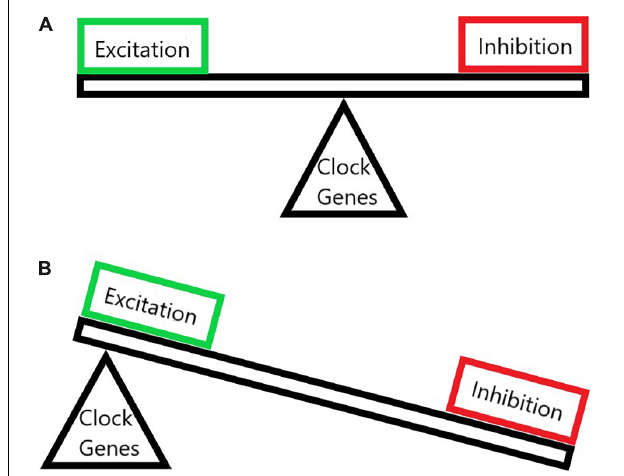
FIGURE 1 | The imbalance of neuronal excitation and inhibition in chronic pain. (A) A normal state where the excitation and the inhibition are balanced upon proper circadian clock gene function. (B) A chronic pain state where clock genes have been altered thus throwing off the balance of pain pathways and allowing for pathologically increased excitation and decreased